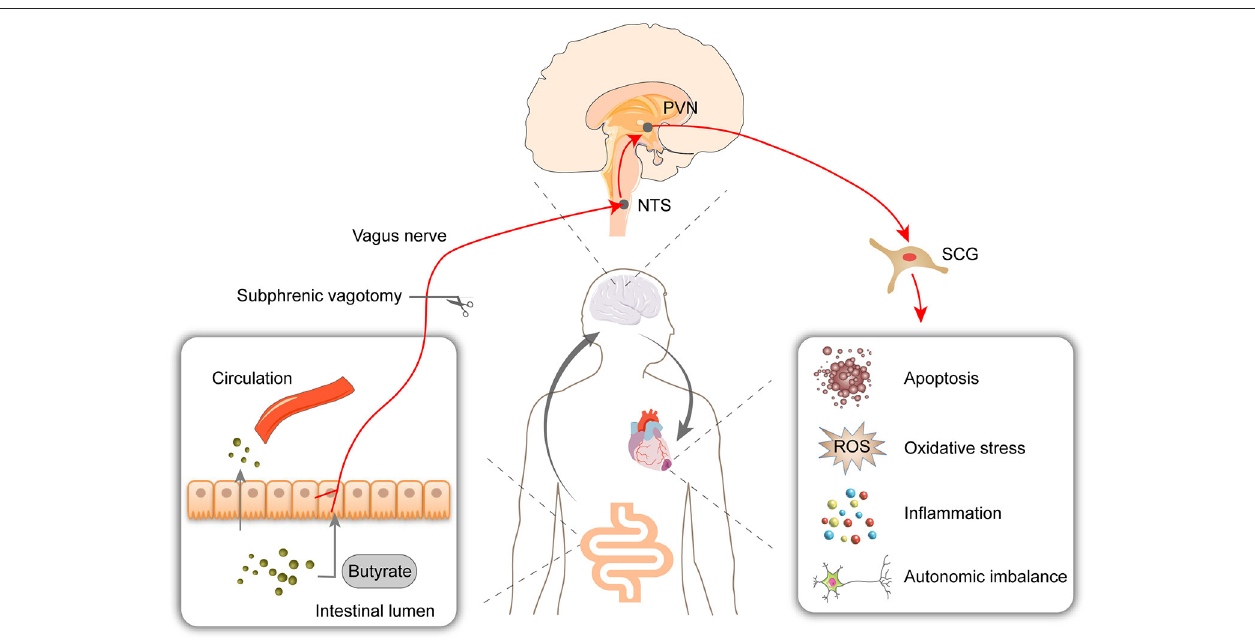
FIGURE 8 | Oral supplementation with butyrate attenuated myocardial ischemia/reperfusion injury via a gut-brain neural circuit, and vagotomy diminished this effect. Other than entering circulation, butyrate might also act on the vagus nerve. The protective effect on autonomic imbalance, oxidative stress, cell apoptosis, and inflammation might due to improving the activation of PVN and SCG induced by I/R. PVN, paraventricular nucleus; NTS, nucleus tractus solitarius; SCG, superior cervical ganglion; ROS, reactive oxygen